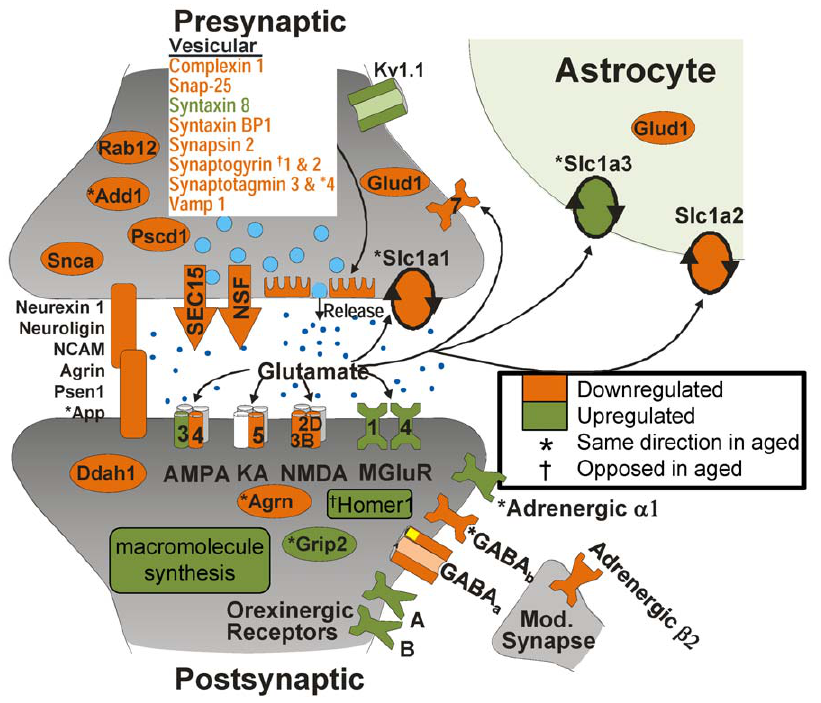
Figure 6. SD targets molecules associated with the glutamatergic synapse. We developed an a priori defined list of genes (101) reported to play a role in glutamatergic neurotransmission. 46 were significantly altered with SD (35 decreasing, 15 increasing. A high proportion of downregulated messages were associated with presynaptic neurotransmitter release and cell adhesion. As a process, macromolecular synthesis appears increased. Genes also found to change with age are noted with an (*- agreed; { opposed). Abbreviations: Add1 - adducin 1 a ; Agrn - agrin; Ddah1 - dimethyl arginine dimethyl aminohydrolase; Glud1 - glutamate dehydrogenase 1; Glutamate transporters ( Slc1a1 - excitatory amino acid transporter 3; Grip2 - glutamate receptor interacting protein 2; Slc1a2 - excitatory amino acid transporter 2, Slc1a3 - excitatory amino acid transporter 1); Kv1.1 - shaker K + channel; Nsf - n-ethylamide sensitive factor; Psen1 - presenilin 1; Pscd1 - pleckstrin homology; Sec15 - secretory factor 15; Snca - alpha